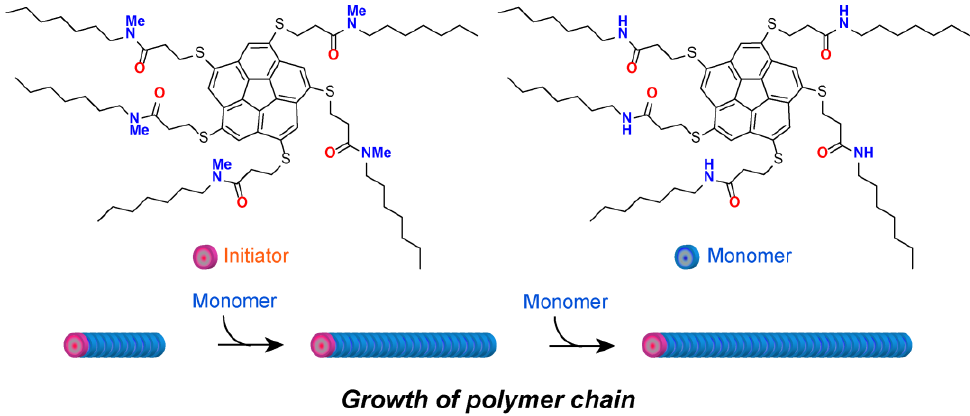
Figure 4. Schematic illustration for supramolecular polymerization of corannulene derivatives having five amide-adducted thioalkyl side chains.